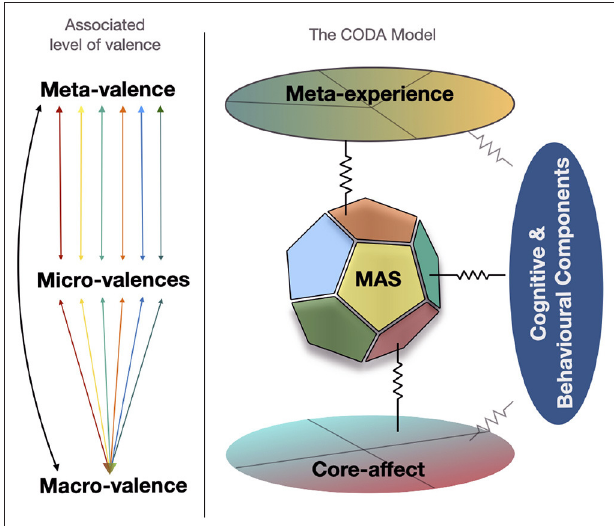
FIGURE 1 | Schematic outline of the CODA model with the associated levels of valence for each dimensional component of the